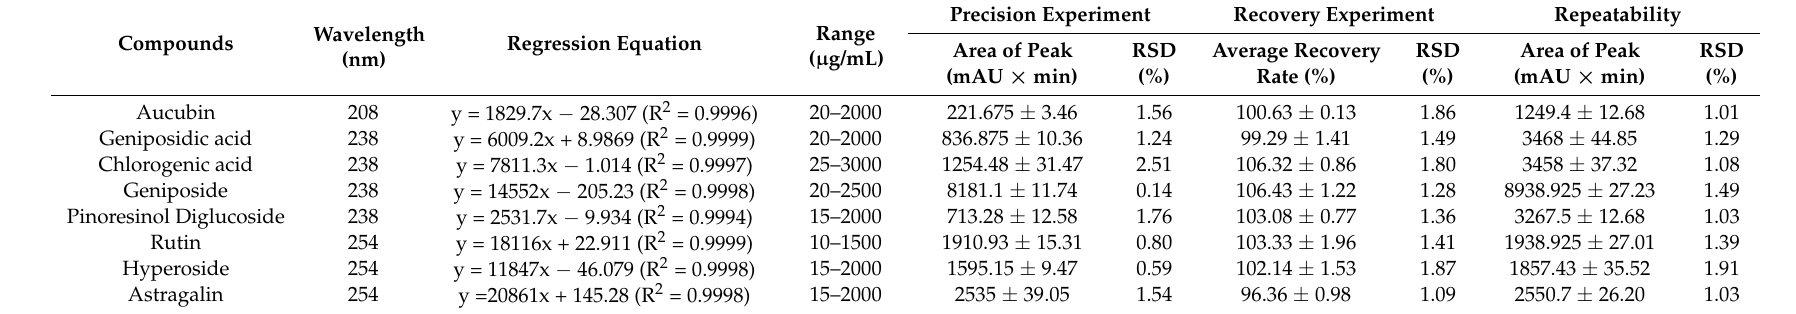
Table 2. Method validation for the quantitative determination of eight compounds.